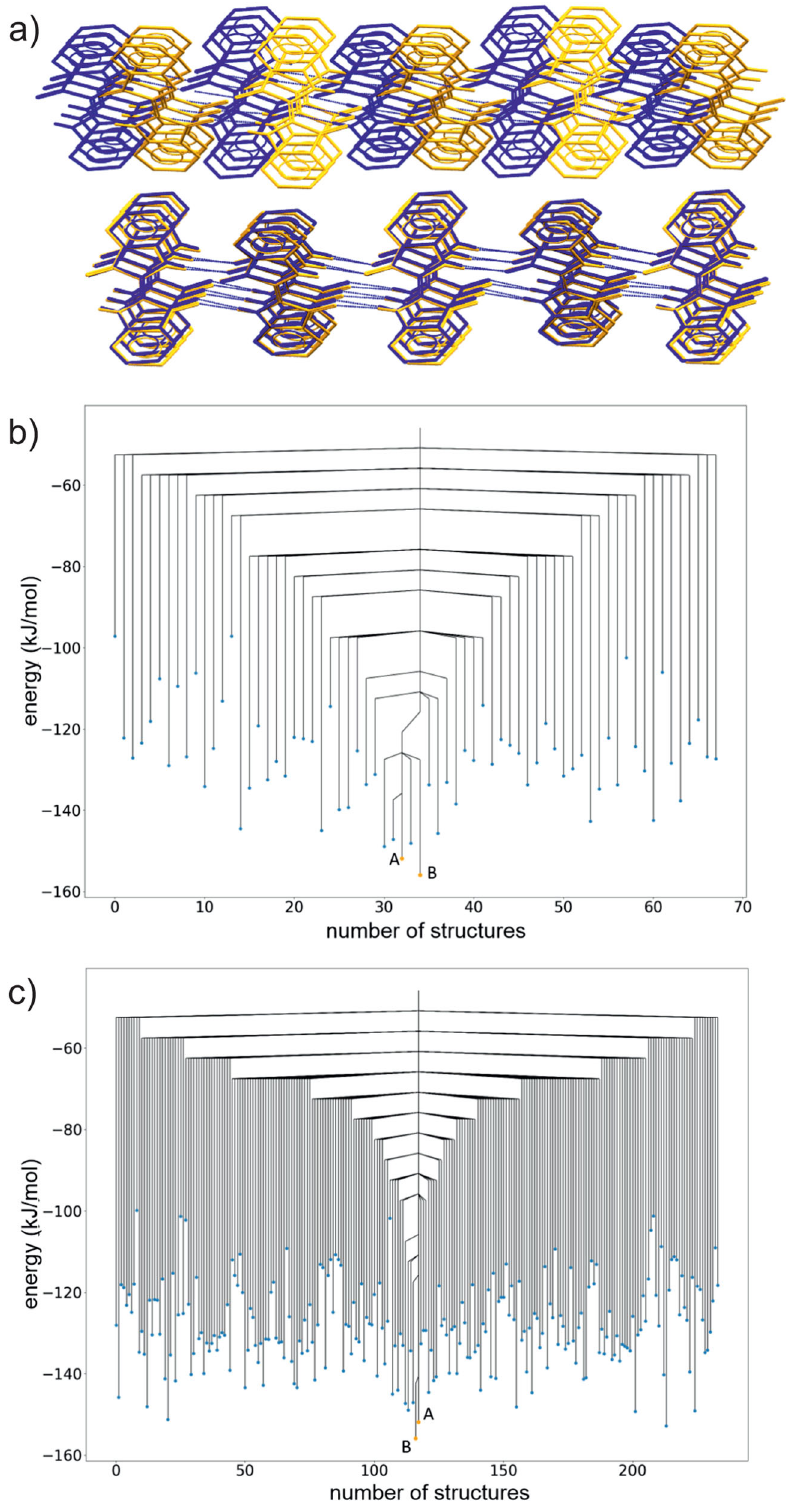
Fig. 3 Structures and disconnectivity graphs for indigo. a Overlay of the packing of polymorphs A (blue) and B (orange) of indigo. Intermolecular hydrogen bonds are shown as blue dashed lines. Non-hydrogen bonding hydrogen atoms are hidden. b , c Disconnectivity graph from threshold simulations for indigo space group b P 2 1 and c P 2 1 / c . Blue points are minimised structures. Orange points represent the initial structures. The horizontal axis labels the number of structures located during the threshold simulation. The number of structures differs between ( b ) and ( c ) due to the different number of structures sampled in the two space groups. The order of structures is chosen to group together structures separated by low energy barriers. A disconnectivity graph showing the entire sampled energy range is shown in Supplementary Fig.